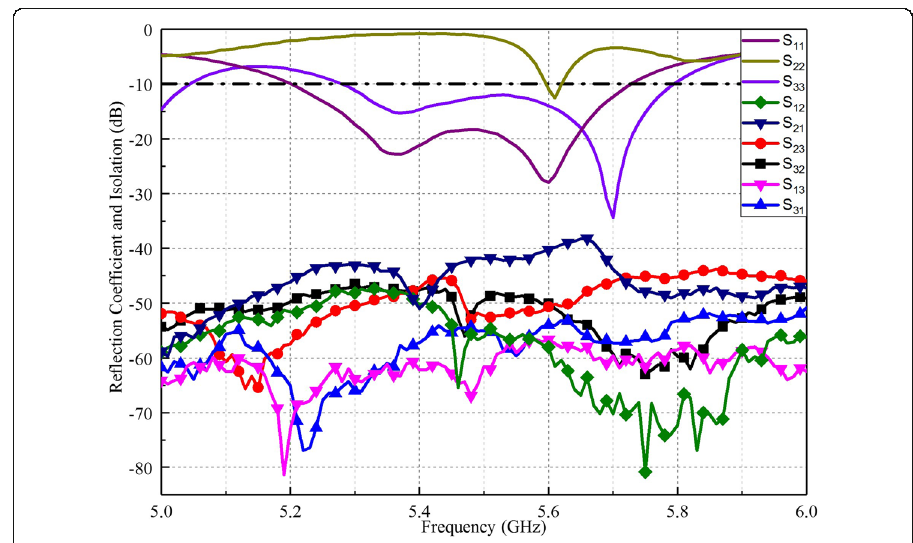
Fig. 10 Measured S -parameters of the three radiating